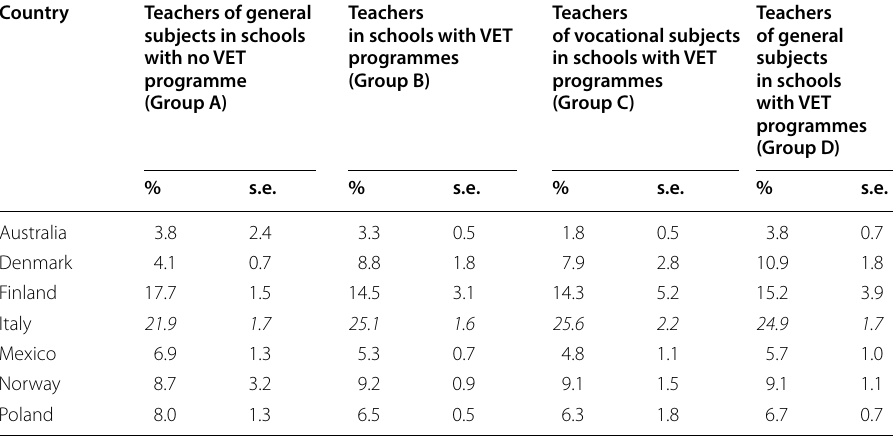
Table 2 Non participation in teachers’ professional development activities: group based on OECD, TALIS 2013)